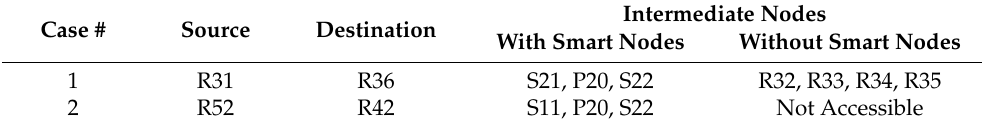
Figure 2. Smart links interconnecting heterogeneous nodes. Table 2. Two cases depicted in Figure